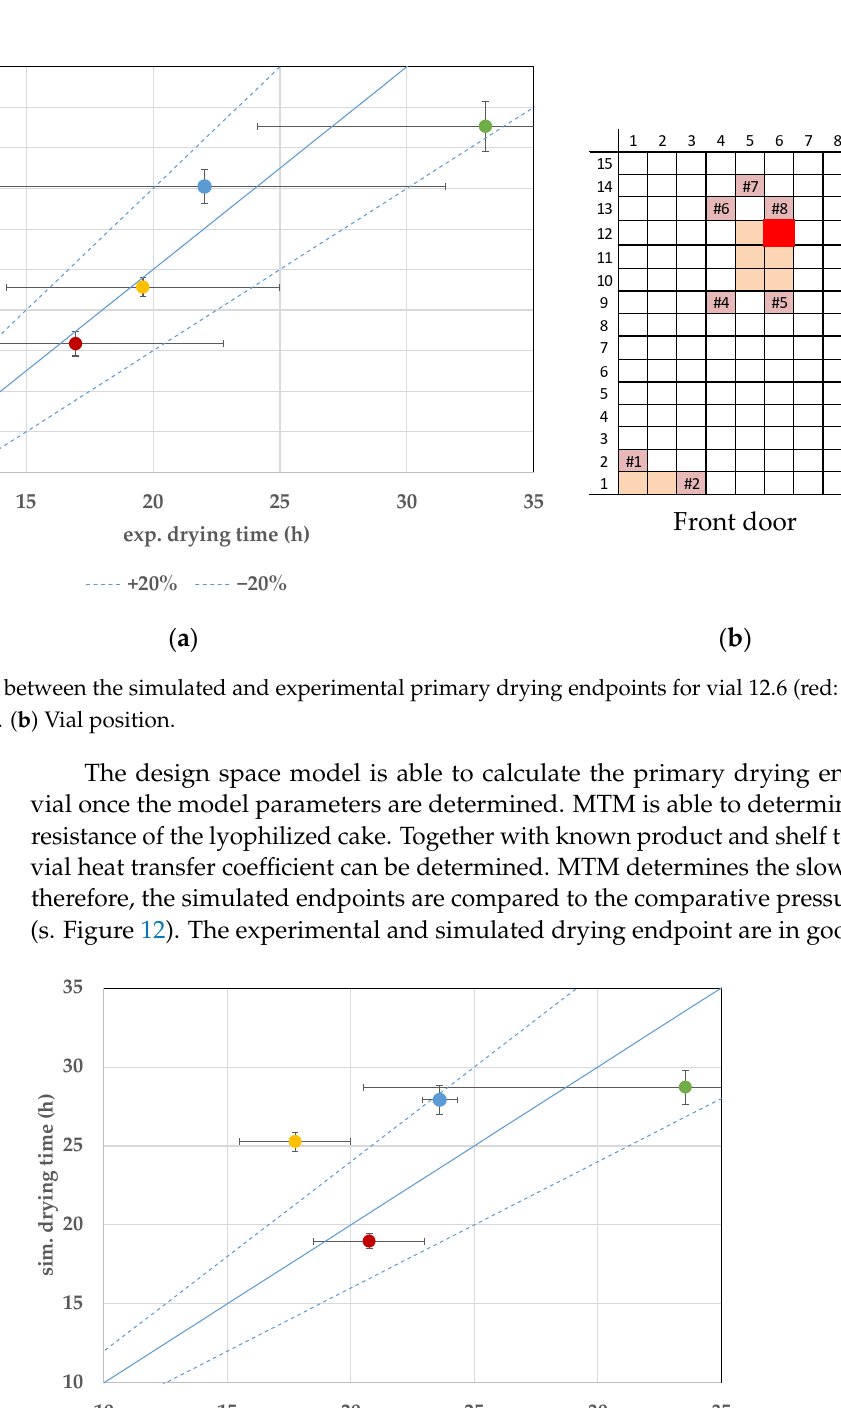
( b ) Figure 10. ( a ) Parity plot between the simulated and experimental primary drying endpoints for vial 2.9 (red: + − , yellow: ++, blue: CP, green: −− ). ( b ) Vial position. Figure 11 shows the simulated and experimental primary drying endpoints for vial 12.9. The closest WTMplus sensor has determined the experimental drying endpoint. Compared to vial 2.9, vial 12.6 finishes drying later. This difference is caused by the edge effect. Vial 2.9 receives a higher radiative heat transfer compared to vial 12.6 and therefore dries faster.